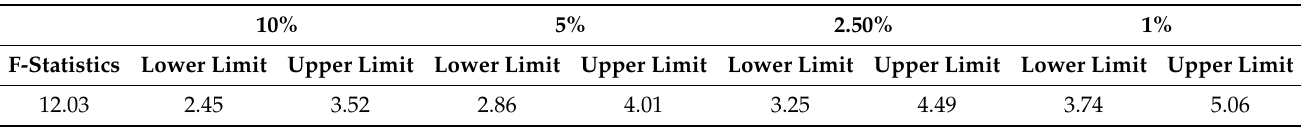
Table 3. Cointegration